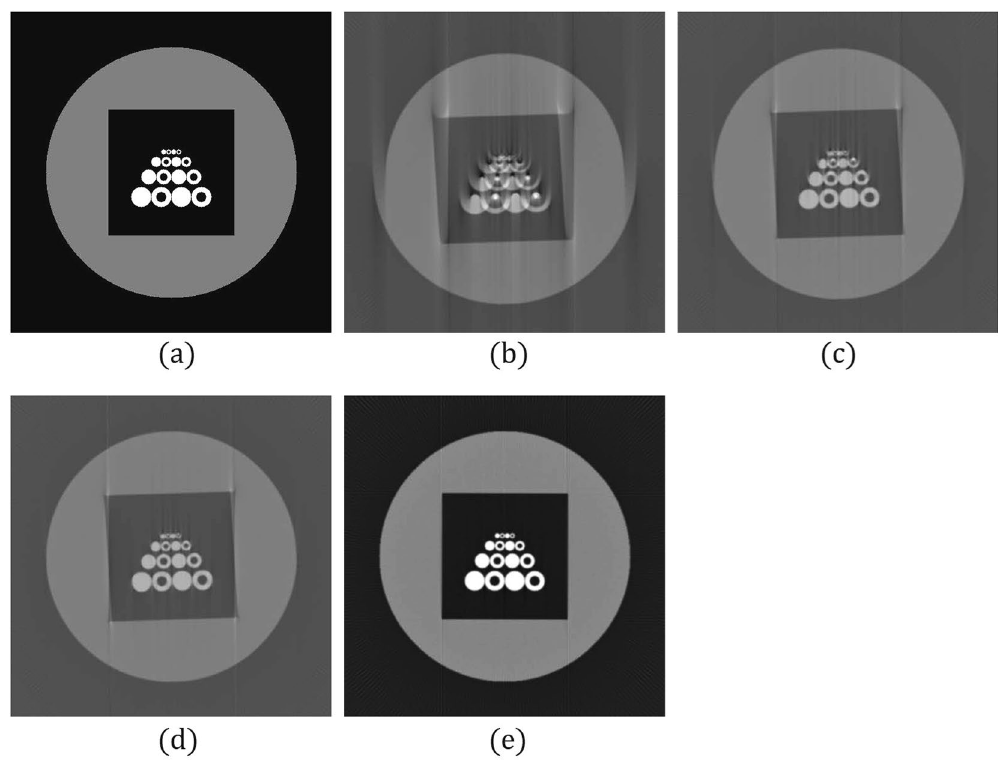
Figure 3. Tomographic images of Phantom 2 reconstructed from 180 projections with 512 parallel beams. The projection angle was 1.02° and the projected rotational axis was biased to the left by 10 pixels. ( a ) Target image. ( b ) Reconstruction result without correcting the errors. ( c ) Reconstruction result when δ B was corrected by the ENP method. ( d ) Reconstruction result when θ E was corrected by the FC method. ( e ) Reconstruction result when δ B and θ E were corrected by the proposed method.